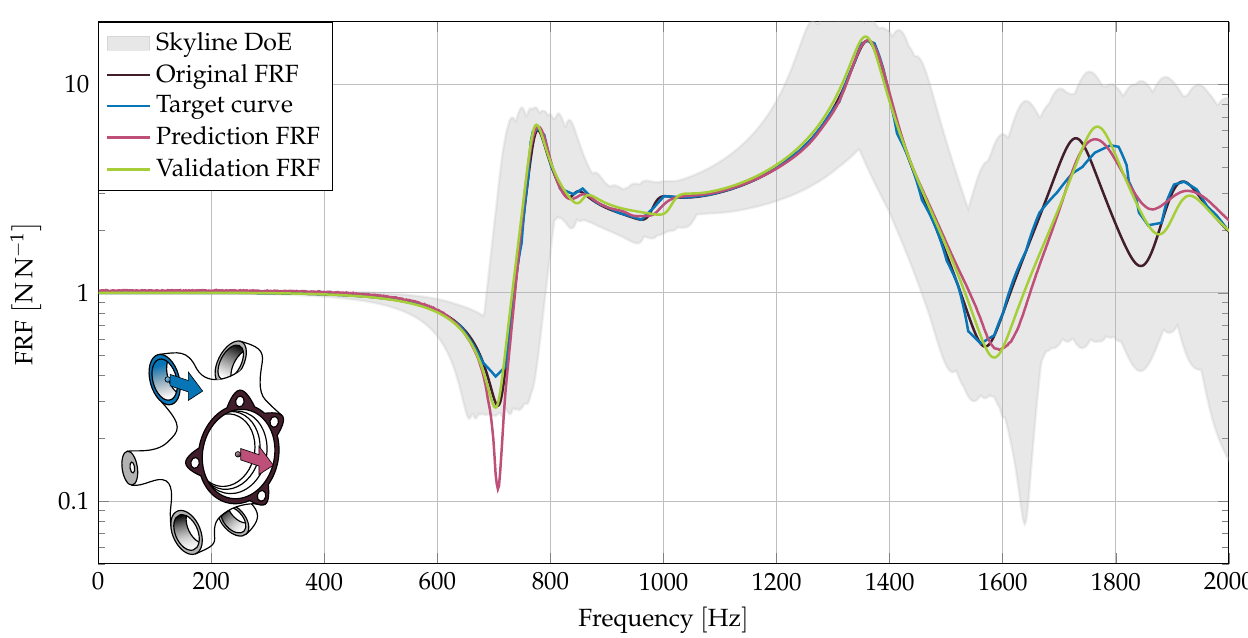
Figure 7. Optimization using a matching-curve to achieve an eigenfrequency raise at 1700Hz. We demanded an eigenfrequency reduction for another FRF, to showcase both direc- tions of change. In Figure 8 we reduce the eigenfrequency at 1900 Hz without an amplitude reduction target. In this case, the target frequency is matched accurately. Both examples show the possibility to move specific component eigenfrequencies. The target curves not only consider the eigenfrequency itself, but also the rising and falling area left and right of the actual eigenfrequency. This width would not be considered by a scalar eigenfrequency optimization.